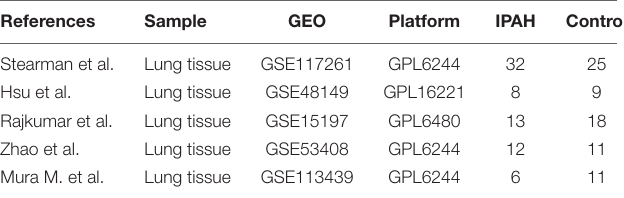
TABLE 1 | Datasets detailed information.